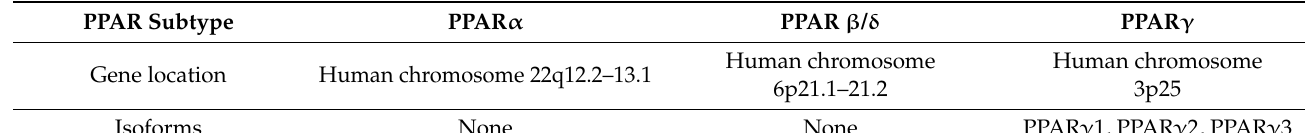
Table 1. Main characteristics of PPAR